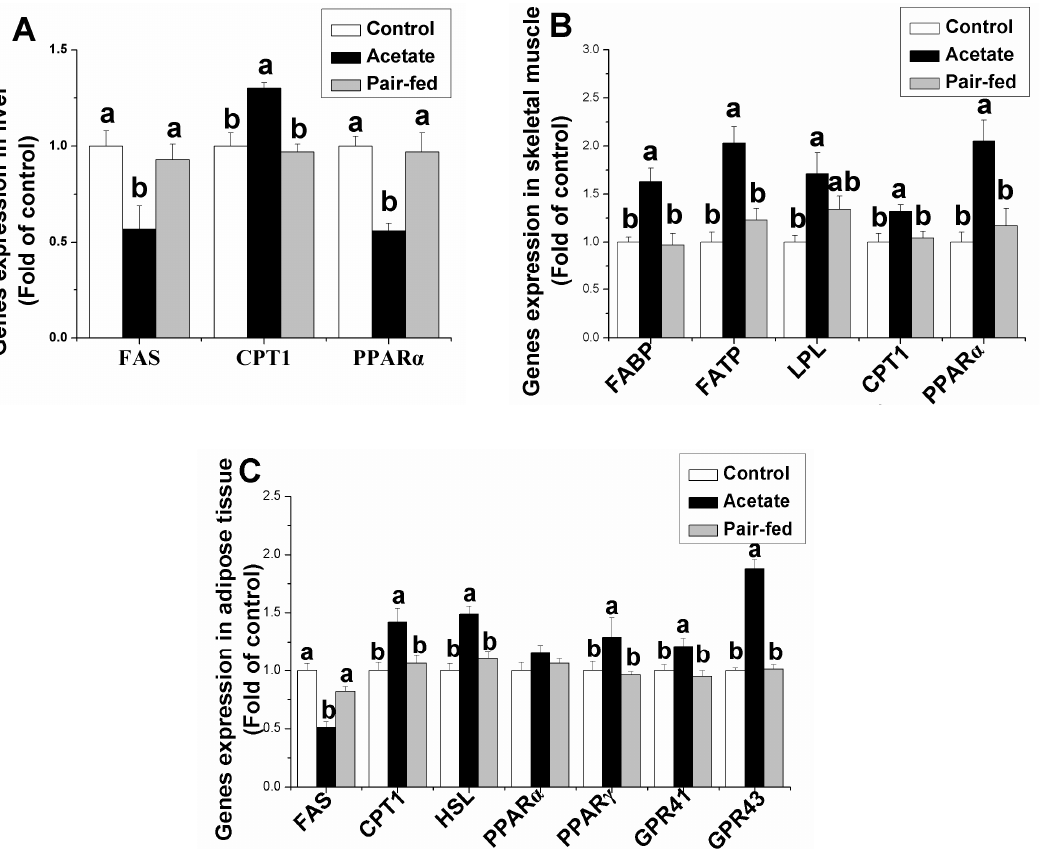
Figure 3. The effect of the acetate treatment on genes expression related to lipid metabolism in liver ( A ), skeletal muscle ( B ) and adipose tissue ( C ). a, b: means with different superscripts are significantly different ( p < 0.05). (Abbreviations: FAS, fatty acid synthase; CPT1 , carnitine palmitoyl transferase 1; HSL , hormone-sensitive lipase; LPL , lipoprotein lipase; FATP , fatty acid transport protein; FABP , fatty acid-binding protein; PPAR , peroxisome proliferator-activated receptor; GPR , G protein-coupled receptor.).